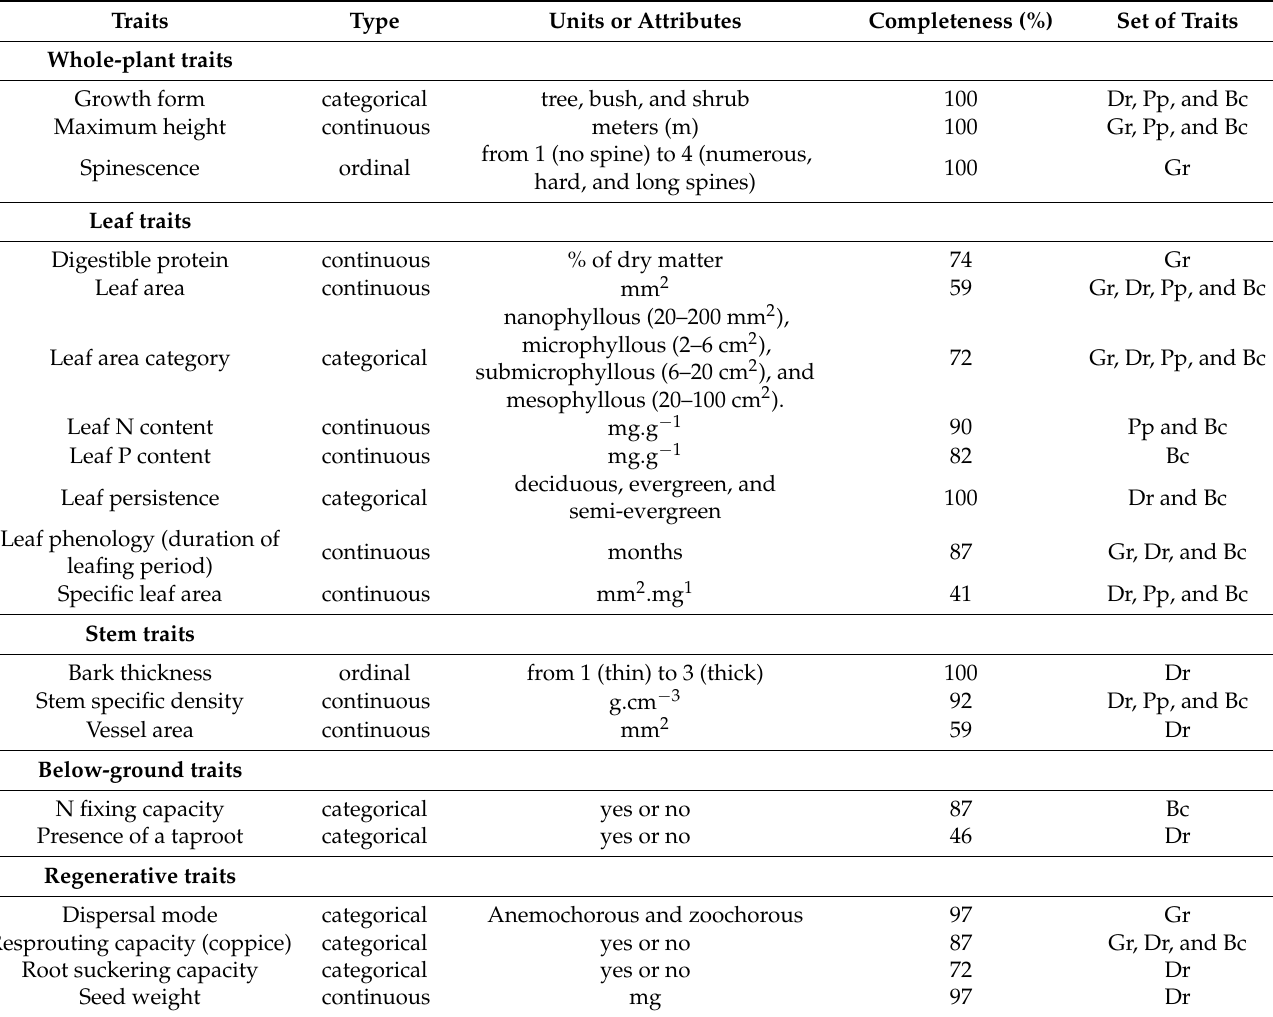
Table 1. List of the selected traits presented in different categories according to what part of the plant they describe. The “Completeness” column indicates in percent for how many species, among the 39 considered, the trait values were found. The last column indicates in which response and effect sets the traits were used (Dr: response to drought, Gr: response to grazing, Pp: effect on primary productivity, and Bc: effect on biogeochemical